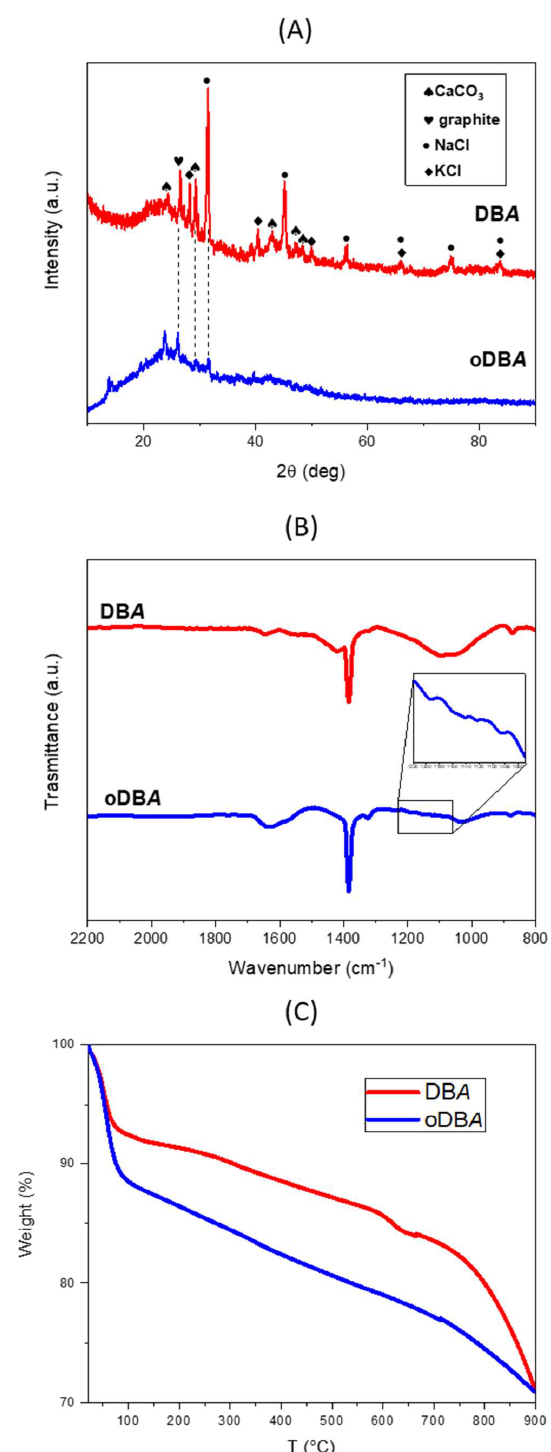
Figure 1. ( A ) X-ray diffraction of dry ball-milled ashes (DBA; blue curve) and oxidized dry ball-milled ashes (oDBA; red curve); ( B ) Fourier-transform infrared (FTIR) spectra of DBA before and after H 2 O 2 treatment; ( C ) thermogravimetric analysis (TGA) scans of un-oxidized and oxidized DBA.